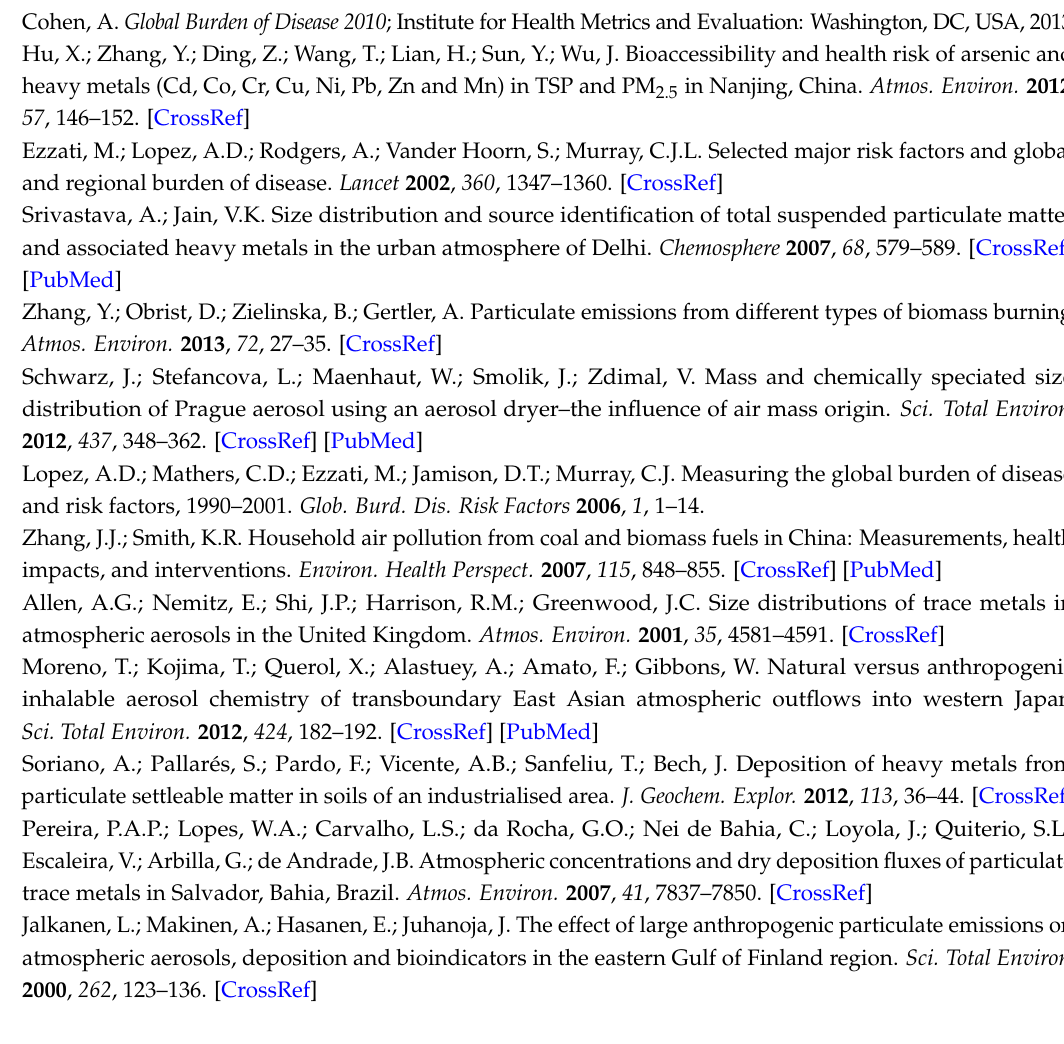
Figure S1: The comparison of wind direction and wind speed between four seasons and collecting days. (a–d) shows the WD and WS in different seasons (data of per hour); (e–h) shows the WD and WS in the collecting days, Figure S2: The comparison of diurnal variation of Temperature, Relative humidity, Wind speed between whole the summer (data of per hour) and collection days in summer, Figure S3: The comparison of diurnal variation of Temperature, Relative humidity, Wind speed between whole the autumn (data of per hour) and collection days in autumn, Figure S4: The comparison of diurnal variation of Temperature, Relative humidity, Wind speed between whole the winter (data of per hour) and collection days in winter, Figure S5: The comparison of diurnal variation of Temperature, Relative humidity, Wind speed between whole the spring (data of per hour) and collection days in spring, Table S1: The date of sixty-four samples, Table S2: The recovery of the two certified materials of soil (GBW07403) and fly ash (GBW08401) ( n =